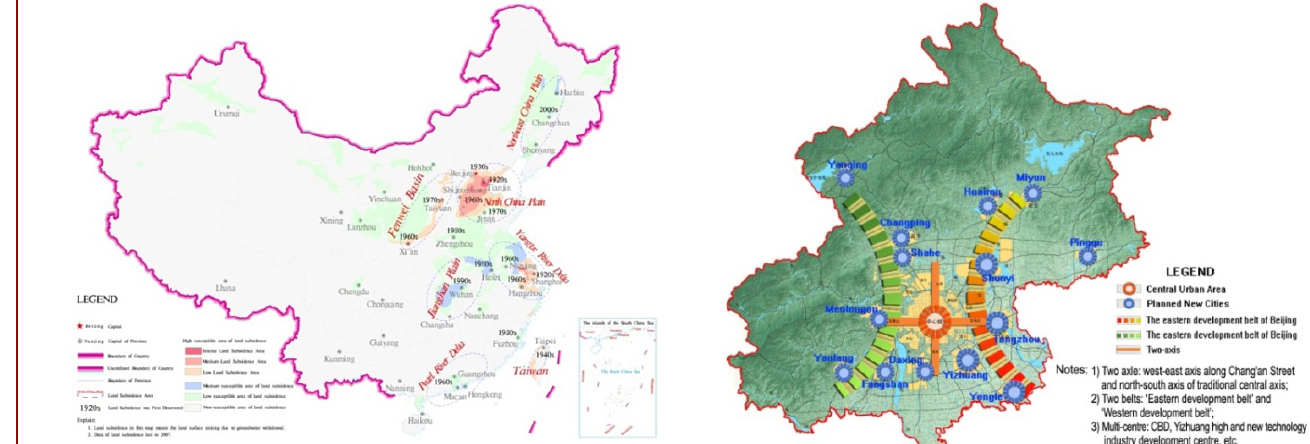
Figure 2. Beijing’s planned spatial structure (2004–2020).